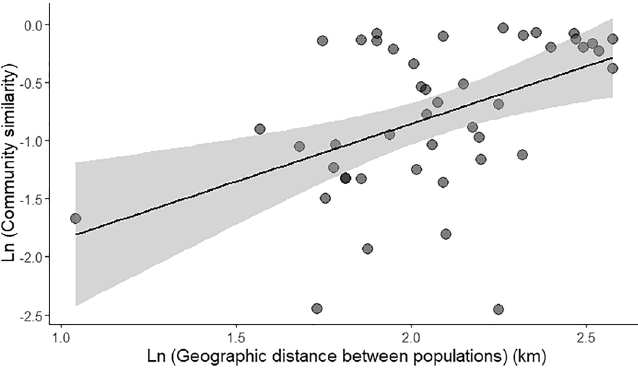
Figure 5. Distance-decay relationship between mosquito species across the Lakshadweep